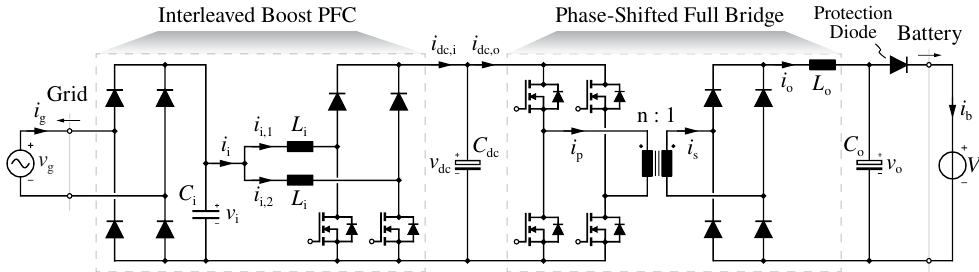
Figure 2. Equivalent circuit schematic of the considered